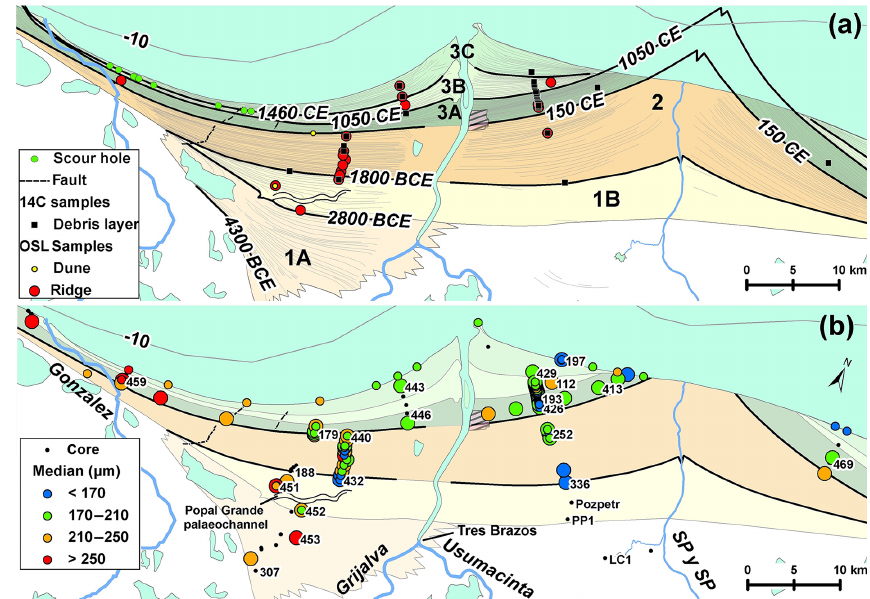
Figure 5. (a) Reconstructed palaeoshorelines (ages in yrCE); (b) median grain size (µm) of wave-formed and aeolian deposits (large and small dots,